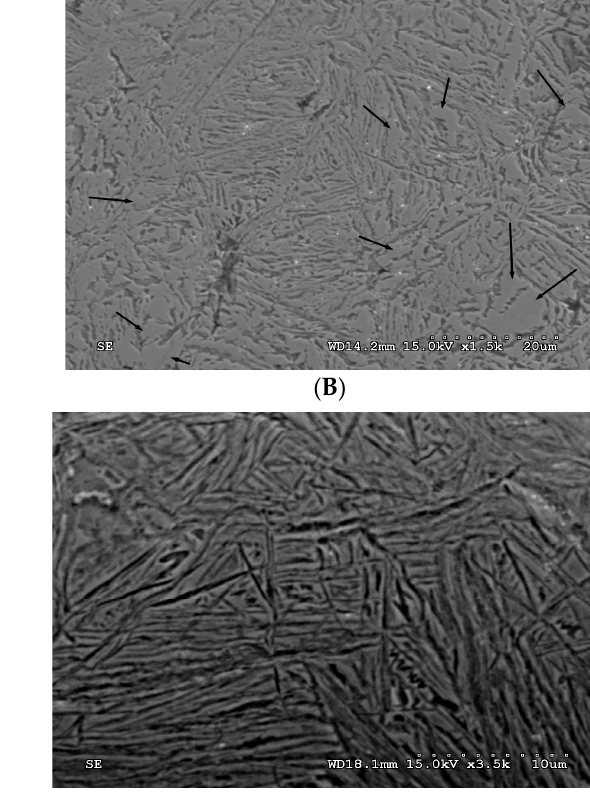
Figure 2. Views of the structure of the tested cast irons. ( A ) The microstructure of the ADI_360 ma- trix with the visible structure of upper ausferrite (OM). ( B ) Block austenite (marked by arrows) in the ADI_360 matrix (SEM). ( C ) The microstructure of the ADI_310 matrix (OM). ( D ) The microstruc- ture of the ADI_240 matrix (SEM).